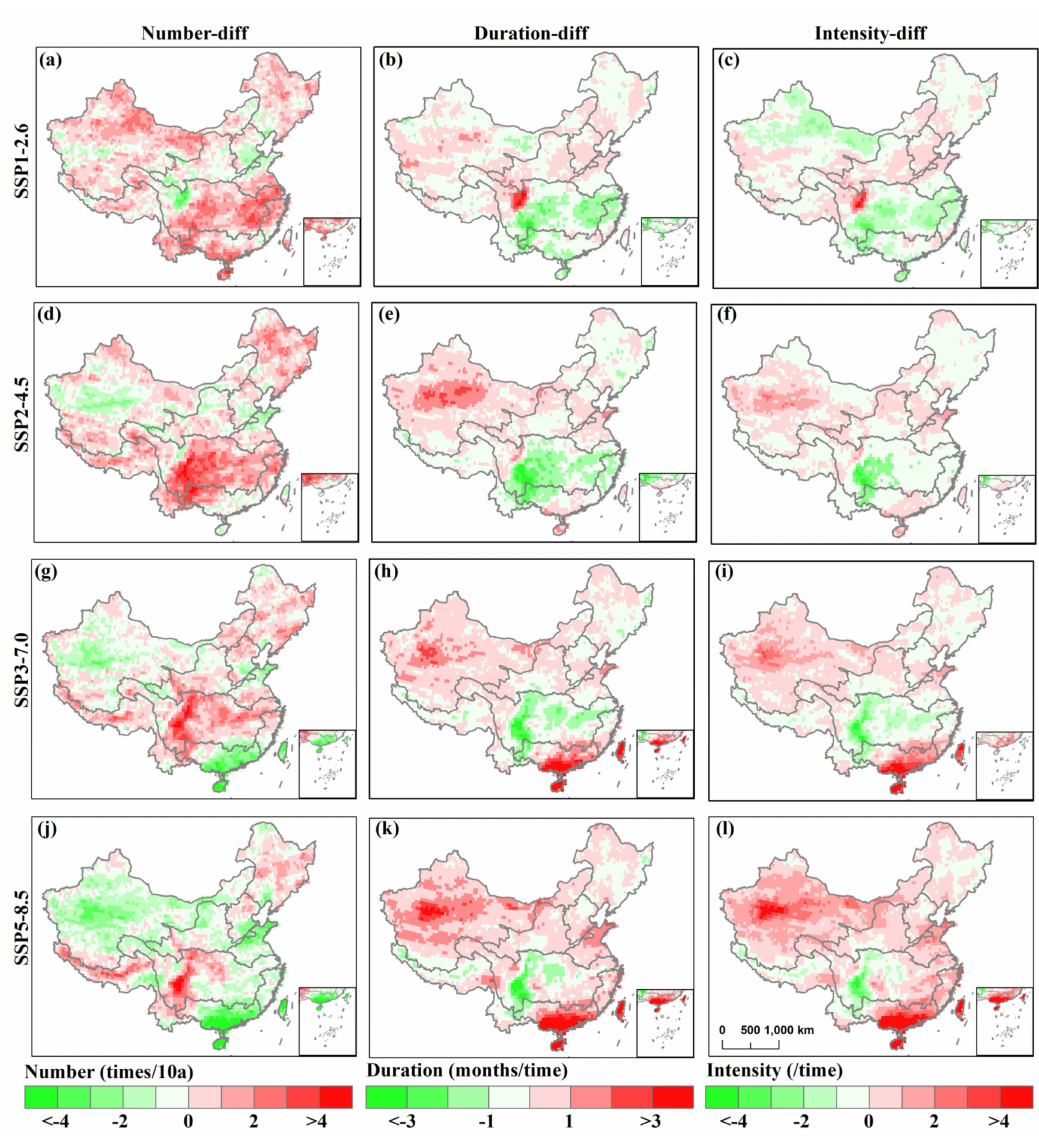
Figure 9. Spatial patterns of differences in DF ( a , d , g , j ), ( b , e , h , k ) DD, and ( c , f , i , l ) DI across China ( d – f ) SSP2-4.5, ( g – i ) SSP3-7.0, and ( j – l ) SSP5-8.5